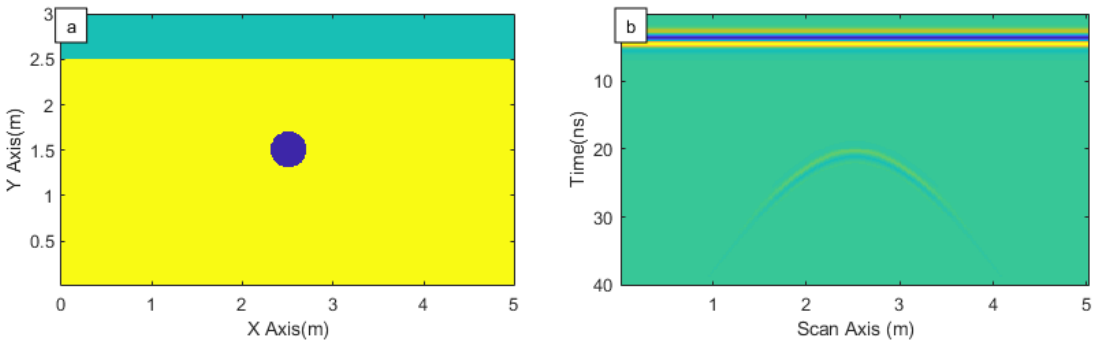
Figure 5. Simulation model of GPR: ( a ) forward geometry model; and, ( b ) simulation signal of GPR.